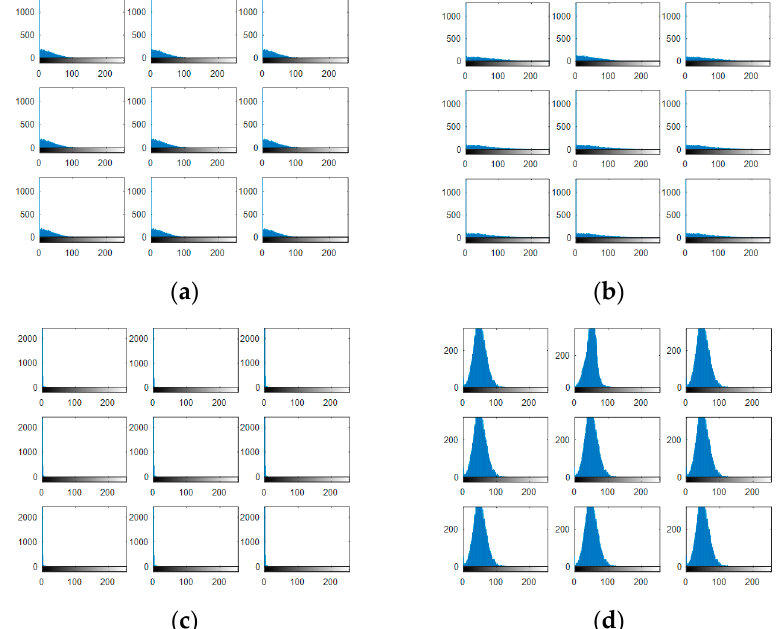
Figure 17. Histograms of encrypted images based on combinations in Figure 15, i.e., ( a ) CFR1, ( b ) CFR2, ( c ) homomorphic transform followed by salting and ( d ) homomorphic transform followed by random kernel convolution.